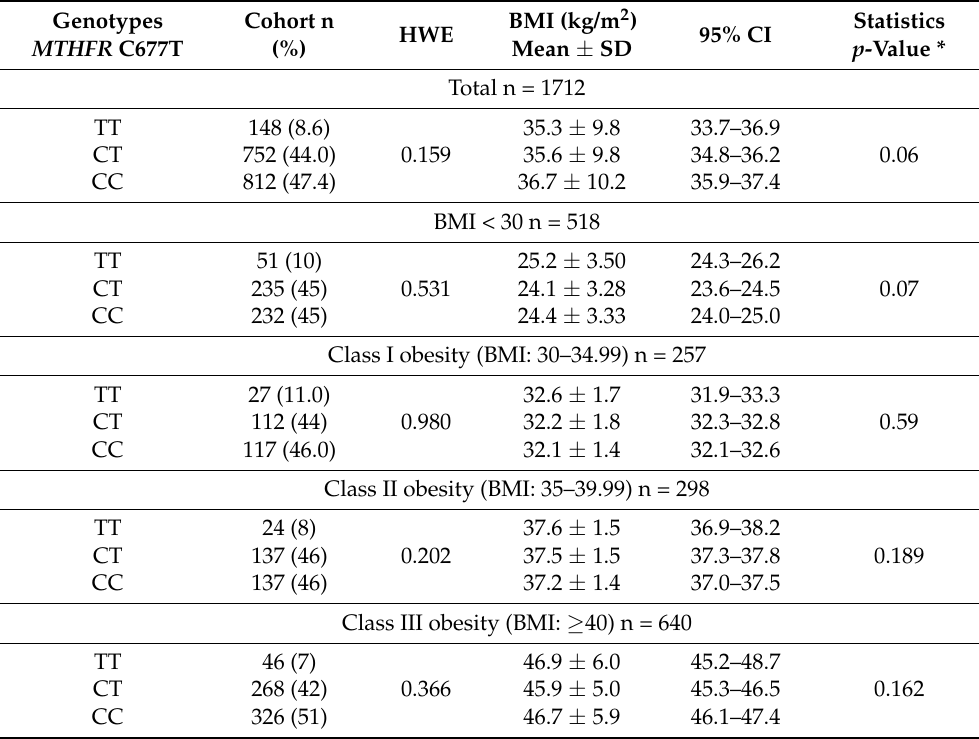
Table 2. Distribution of BMI (body mass index) in studied adults, n = 1712, stratified by MTHFR